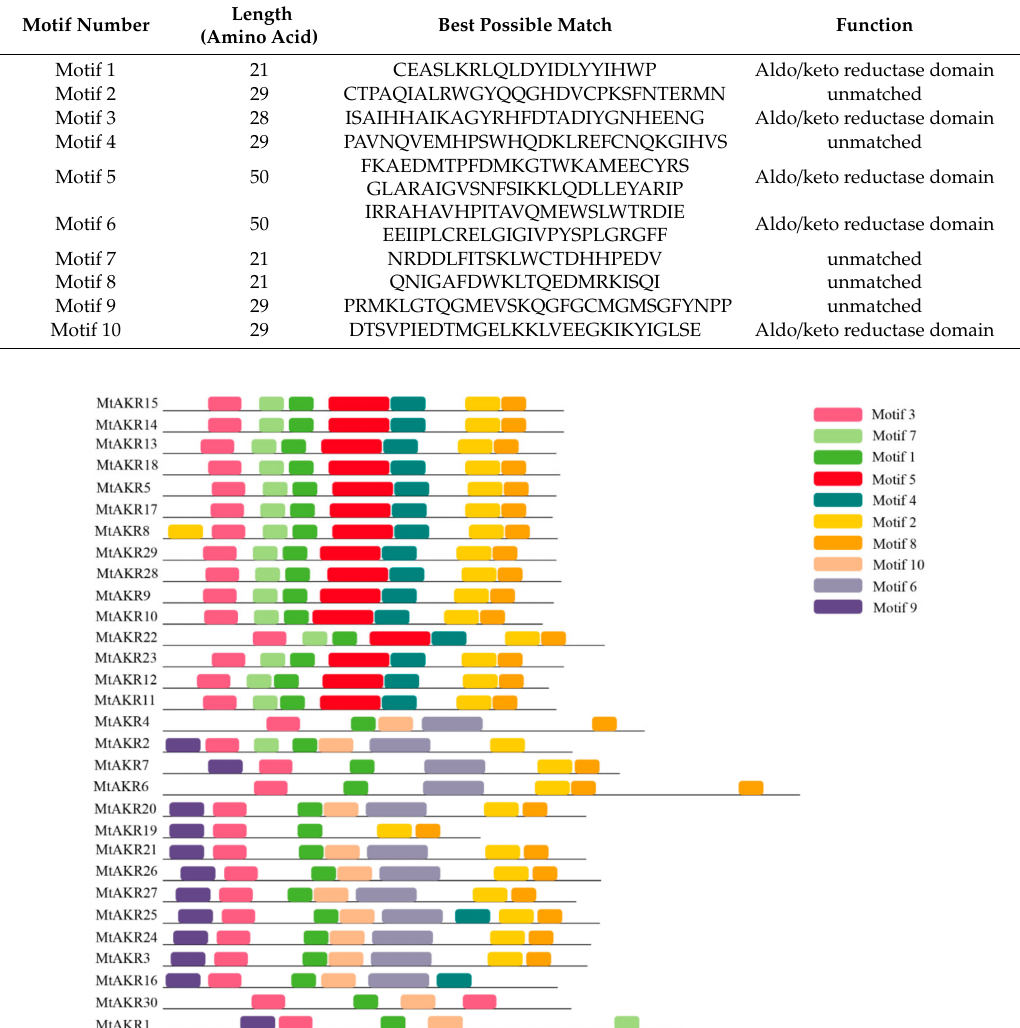
Table 2. Amino acid composition and function of di ff erent motifs.